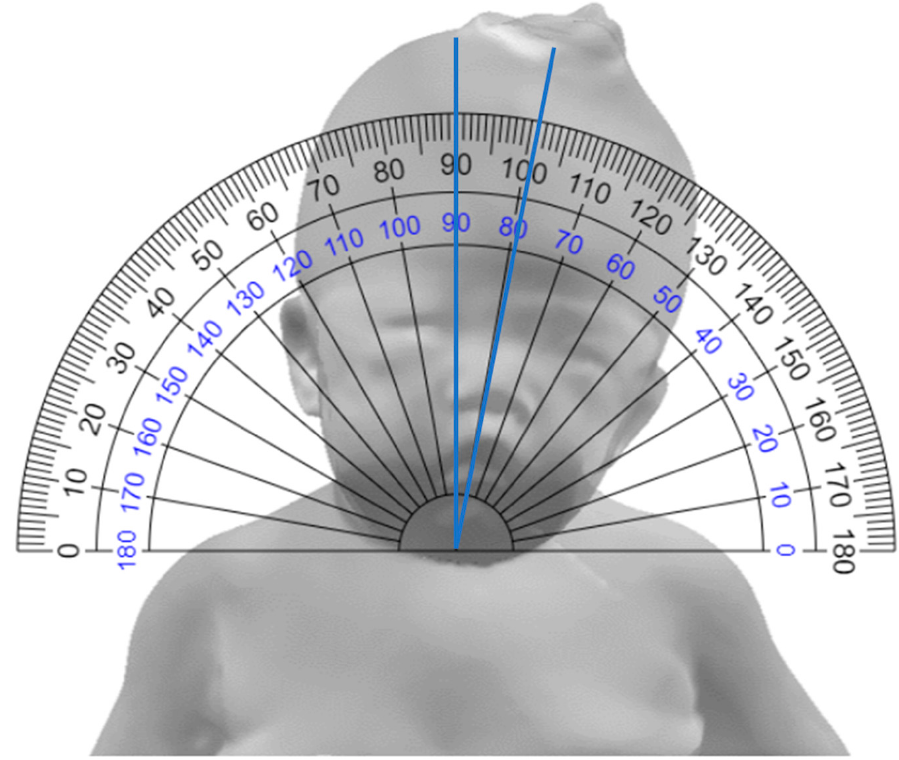
Figure 1. Goniometer method.